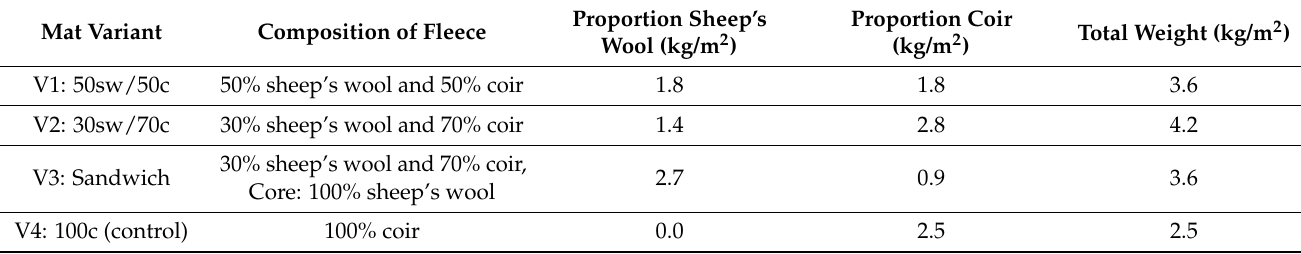
Table 1. Composition of vegetation mats and their weight proportion of air-dry